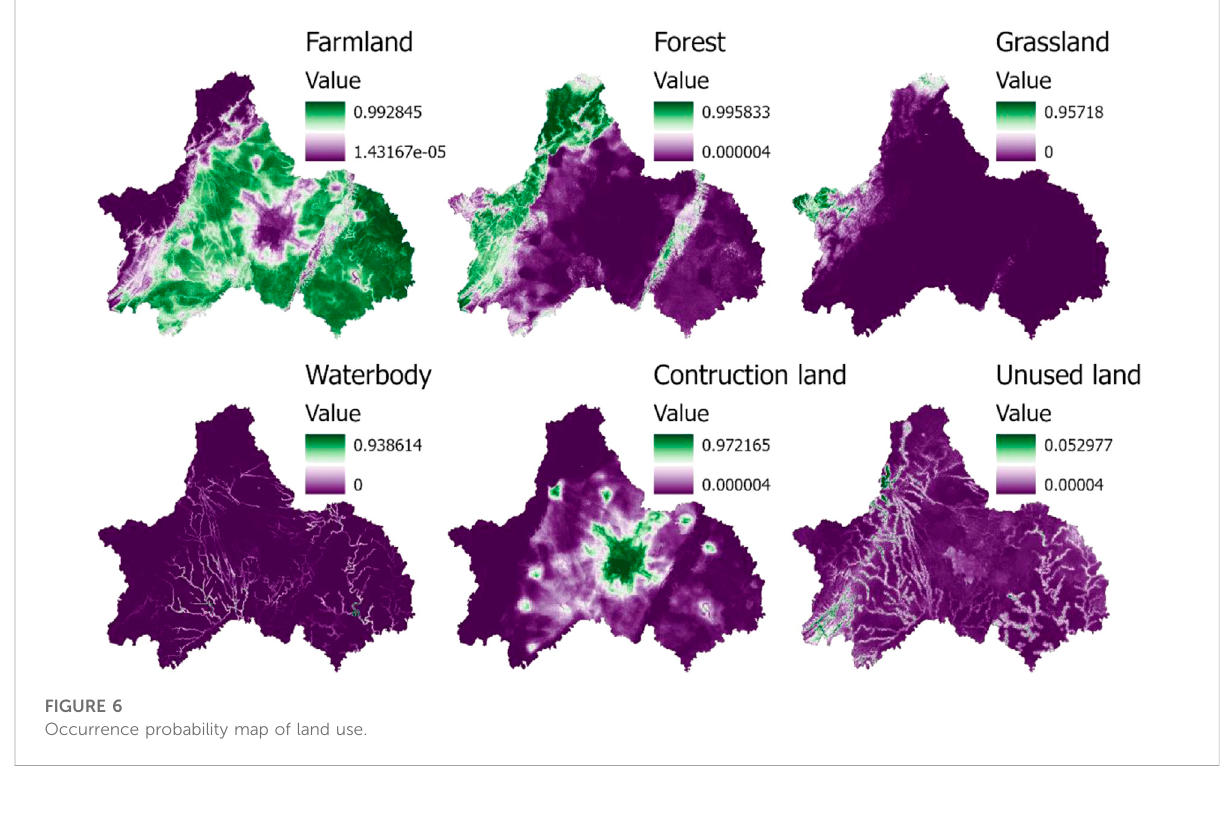
FIGURE 6 Occurrence probability map of land use.